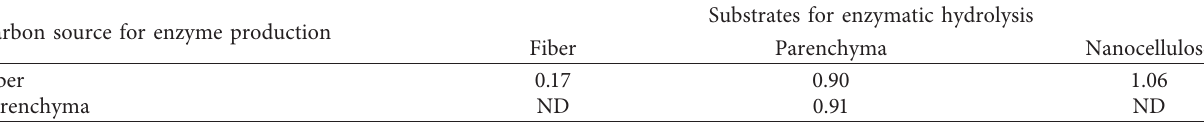
Table 1: Enzymatic hydrolysis of different sources of cellulose (expressed in mg/mL glucose). Carbon source for enzyme production